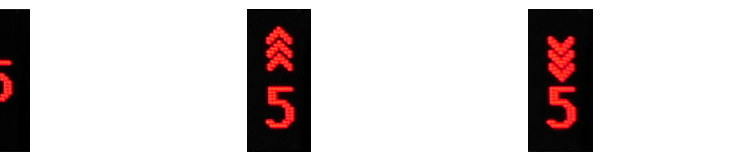
Figure A2. Display panel on the wall in the elevator hall that shows the elevator reaching and leaving the fifth floor.